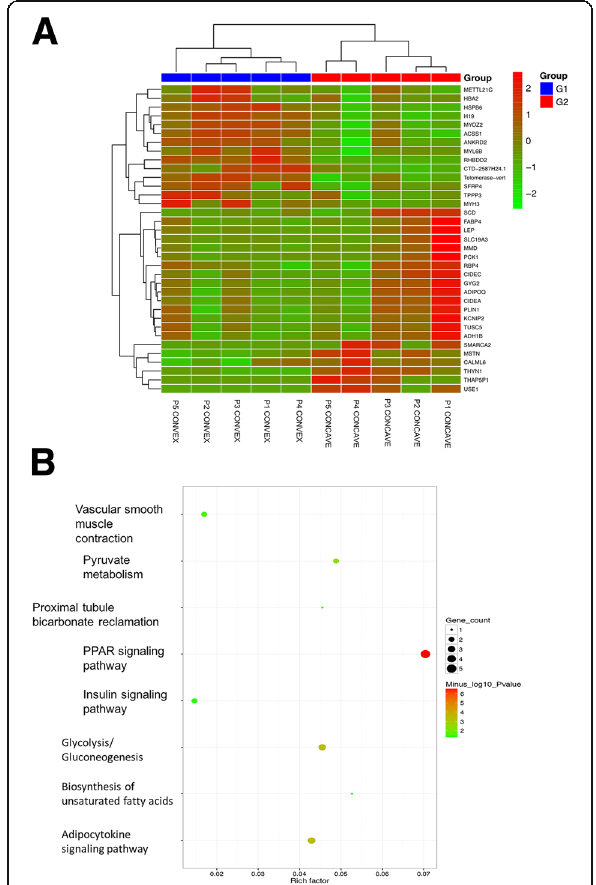
Fig. 1 Differentially expressed genes in convex/concave paravertebral muscles in AIS. a Heat map and hierarchical tree comparing differences in gene expression in convex-sided (G1) and concave-sided (G2) paravertebral muscle of AIS patients ( n = 5). Each line represents the changes (direction and intensity) in each transcript, and each column represents an individual sample according to group (P1CONCAVE represents the concave sided muscle sample of patient 1 and P1CONVEX represents the convex sided muscle sample of patient 1). The lines represent transcripts altering between two sides ( p <0.05 and fold change>2). b KEGG enrichment analyses of differentially expressed genes (DEGs). The prominently over-represented pathways included those for PPAR signaling pathway and biosynthesis of unsaturated fatty